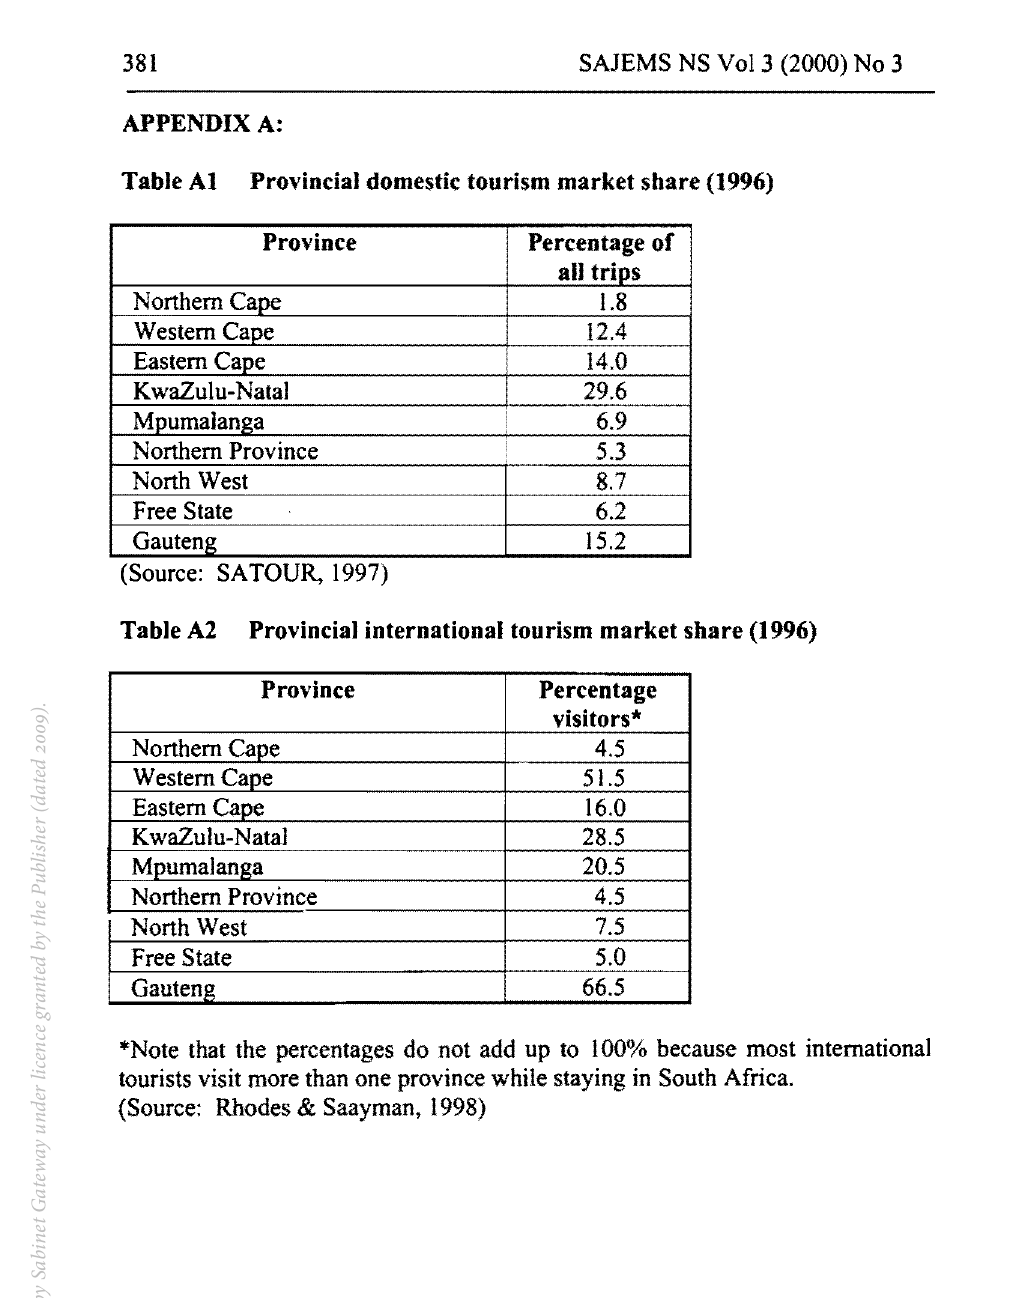
Provincial domestic tourism market share (1996) Province Percentage of all trips